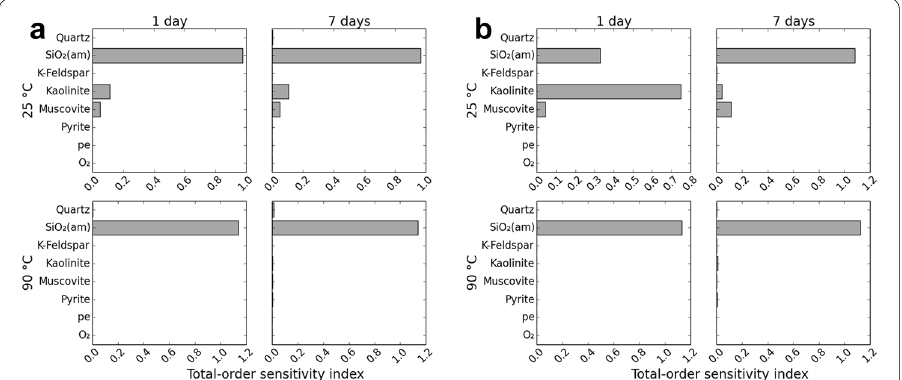
Fig. 9 Calculated total-order sensitivities for Si release depending on temperature after 1 and 7 days, respec- tively, from a the Hettangian sandstone and b the Sinemurian siltstone